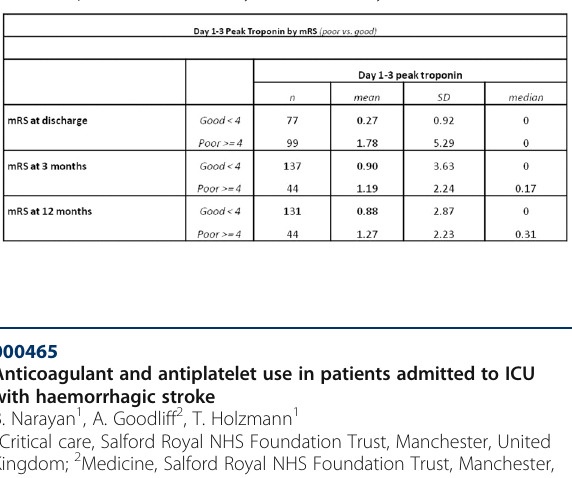
Table 1 (abstract 000419). Mean peak cTnl values associated with good and poor functional ability as measured by mRS after